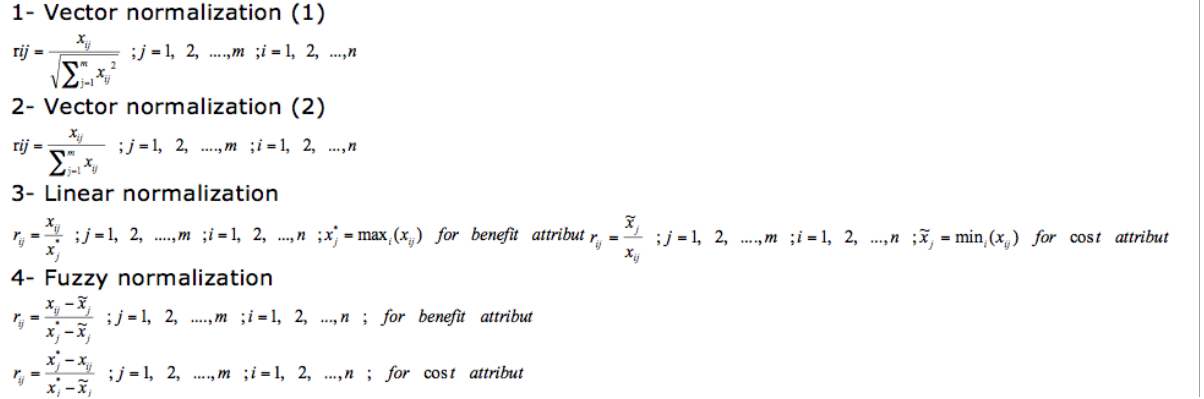
Table 1. Common methods of normalization for